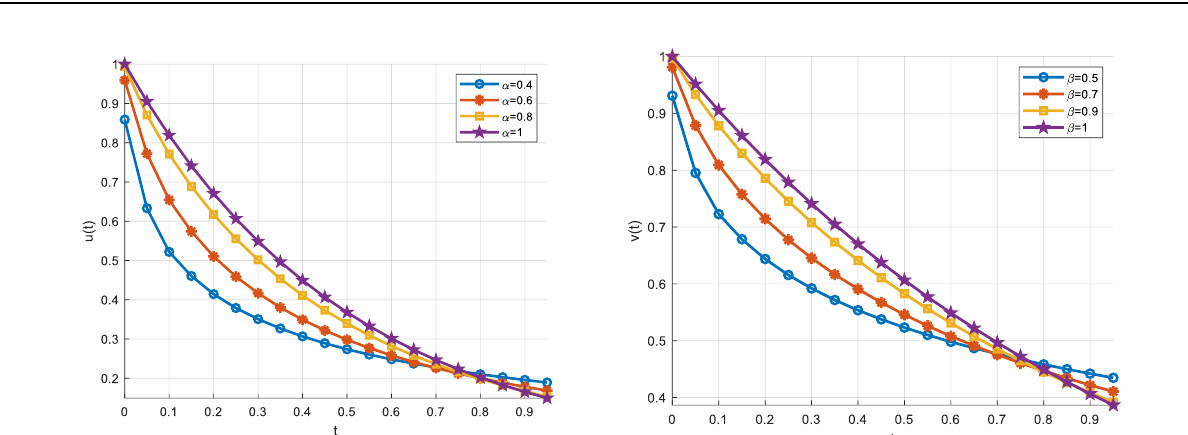
Figure 3. Numerical and exact solutions of